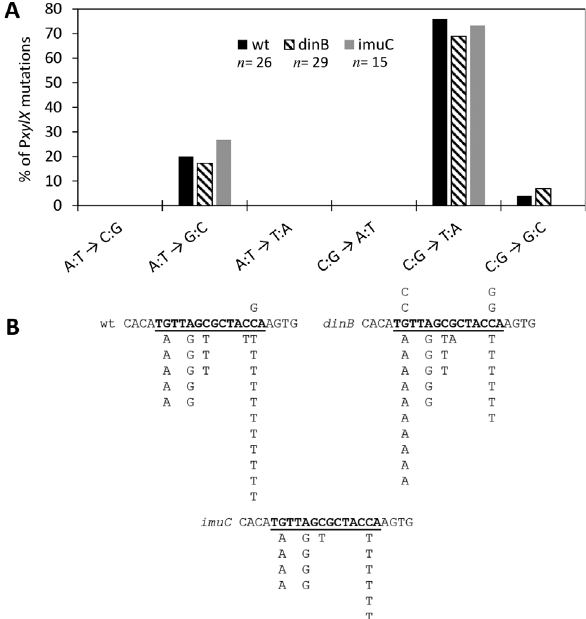
Figure 5 - P xylX mutations. ( A) Distribution of the different base substitu- tions in P xylX in wt (parental strain), dinB and imuC strains. The different base substitutions are indicated. n indicates the number of mutants ana- lyzed in each strain. (B) A small region in the P xylX region is shown, with the XylR binding site underlined. Sequences above and below the line show the different mutations